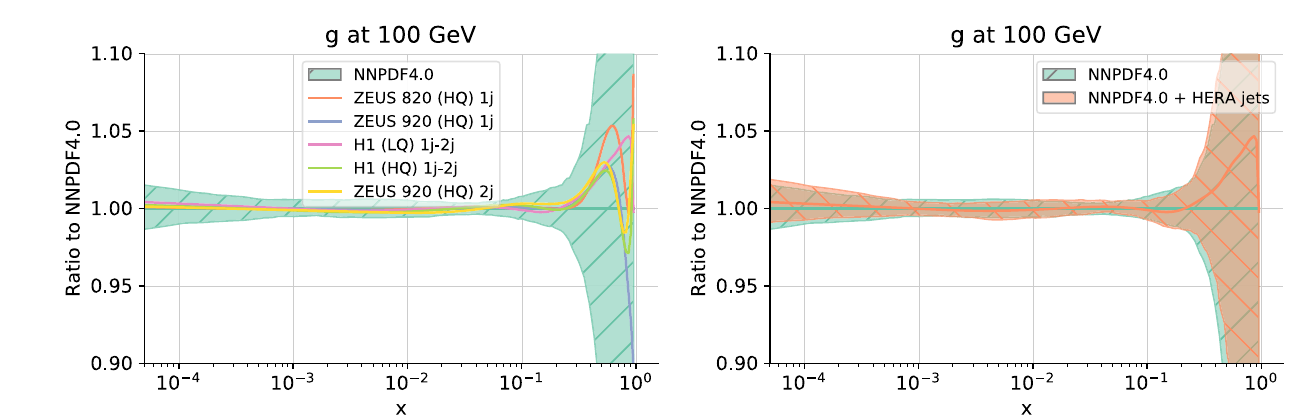
Fig. 44 The gluon PDF obtained reweighting the NNPDF4.0 baseline with DIS jet data, shown as a ratio to the former at Q = 100 GeV. We show the central gluon obtained when reweighting with each of the DIS